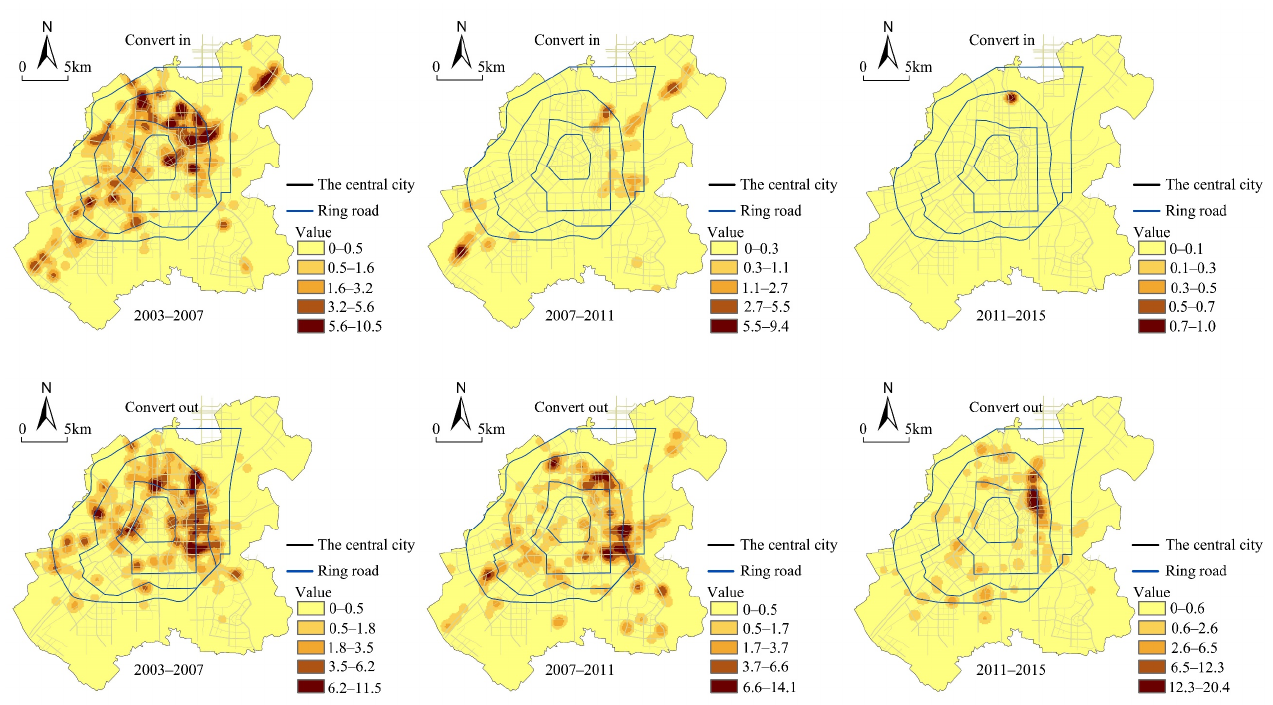
Figure 13. Kernel density map of industrial land conversion in different periods.